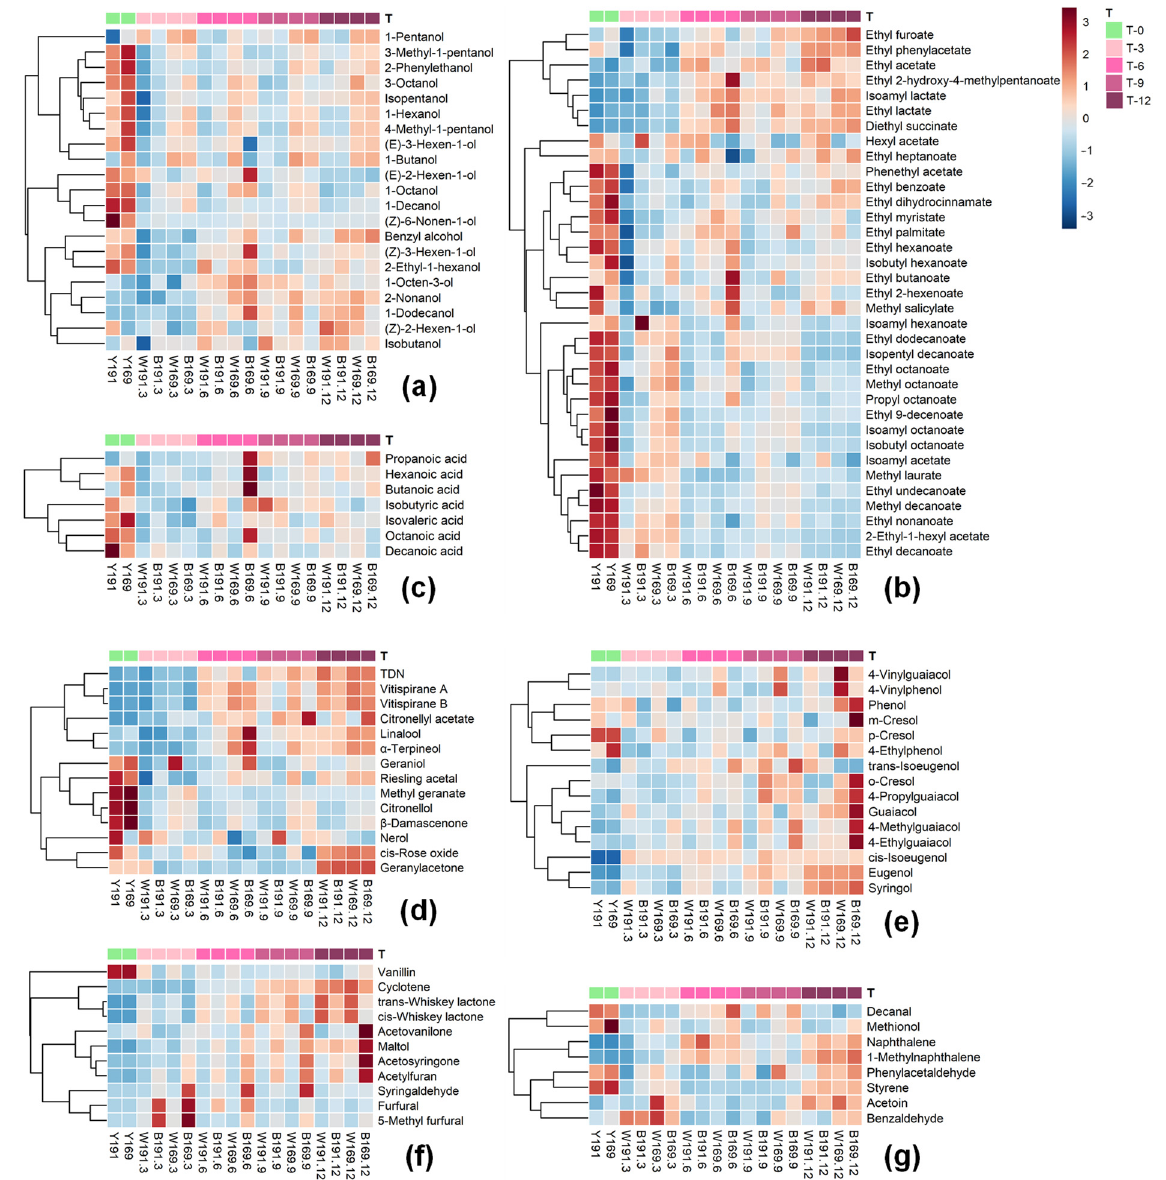
Figure 1. Clustered heatmaps of volatile compounds in wine made of clone 169 and 191 aged in two types of oak barrel during the aging process. T-0, T-3, T-6, T-9, and T-12 represent before aging, 3-month aging, 6-month aging, 9-month aging, and 12-month aging, respectively. Y191 and Y169 represent wine made of clone 191 and 169 before aging, respectively. W191 and W169 represent wine made of clone 191 and 169 aged in Wolin oak barrel for 12 months, respectively. B191 and B169 represent wine made of clone 191 and 169 aged in Bordeaux oak barrel for 12 months, respectively.